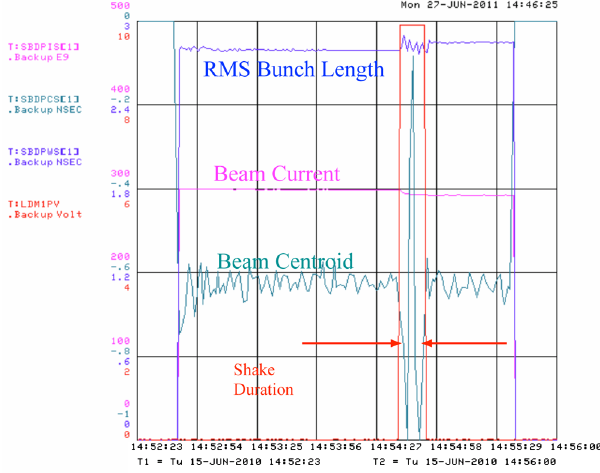
FIG. 5. The data from the SBD system taken at 150 GeV is plotted here: T:SBDPWS, T:SBDPIS, and T:SBDPCS. The beam is modulated for 14 s and there is some beam loss and bunch length growth. Although the measured bunch centroid looks like it is still oscillating, the snapshots show that the dancing has stopped. See Fig. 6.